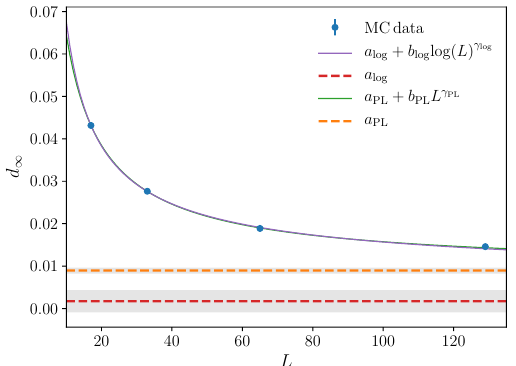
Figure 9 . Distance d 1 (see eq. (5.3)) between the measured R MC function of L for Q = 4. The data can be (cid:12)tted both with a logarithmic scaling a log + b log log( L ) (cid:13) log and with a power law model a PL + b PL L (cid:13) PL . We obtain a log = (1 : 7 the theory) and a PL = (9 : 0 0 : 7) 10 (cid:0) 3 ; see main text for a discussion. The shaded area are the (cid:6) (cid:1) errors in the determination of a PL and a log